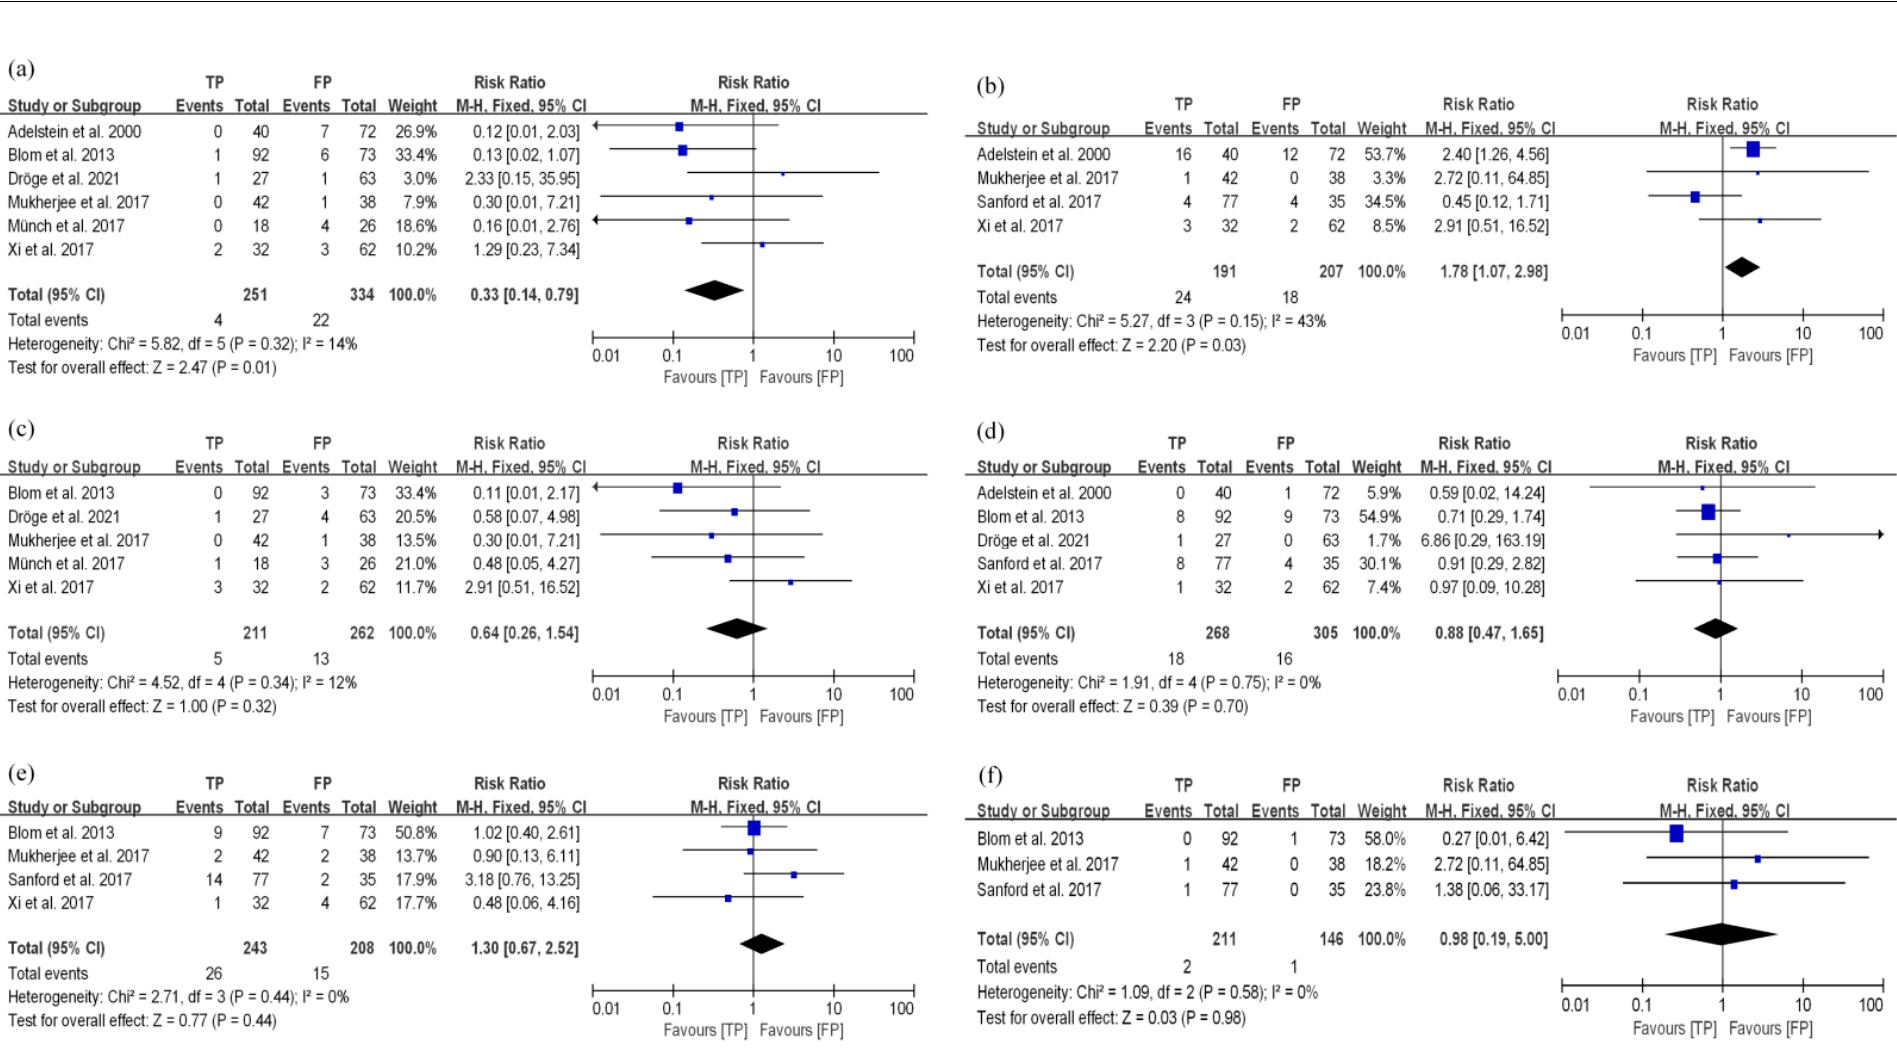
Figure 7. Related toxicity of TP and FP in EC patients treated with nCRT. ( a ) thrombocytopenia; ( b ) febrile neutropenia; ( c ) anemia; ( d ) nausea/vomiting; ( e ) esophagitis; ( f ) diarrhea.